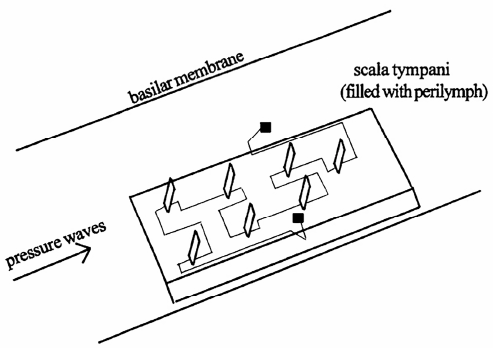
Figure 7. The schematic of vertical PVDF cantilevers device positioned in the scala tympani of a cochlea [58]. Reprinted by permission from Springer Nature Customer Service Centre GmbH: Springer Nature MRS ONLINE PROCEEDINGS LIBRARY Considerations in the Development of a Piezoelectric Transducer Cochlear Implant, N. Mukherjee et al., COPYRIGHT (2011). Polyvinylidene fluoride (PVF 2 ) offers the highest sensitivity of piezoelectric bending amongst other organic piezoelectric polymers [59]. Mukherjee et al. have developed PVF 2 cantilevers with nickel (Ni) and copper (Cu) as the electrodes [59]. PVF 2 is stretched 300% to attain its piezoelectric β phase characteristics. Underwater acoustic measurement reveals three bending modes under 1 kHz that the cantilevers exhibit, which are strongly correlated with the cantilever length and thickness. The sensitivity measurements of Ni/PVF 2 /Cu cantilevers demonstrate the amount of voltage generated from the cantilevers with respect to sound pressure in fluid environment. The voltage generation from this piezoelectric device depends on the applied sound pressure level where the sensitivity is measured to be 0.15 mV/Pa at 125 dB SPL and 0.05 mV/Pa at 150 dB SPL.There is a triple decrease in sensitivity with respect to the ten times increase in the applied acoustic pressure waves.